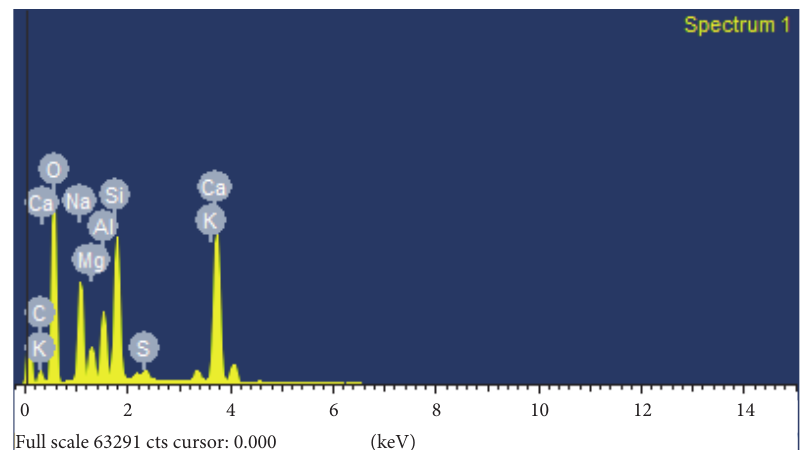
Figure 3: Measurement of the elements present in the sample by EDX analysis.